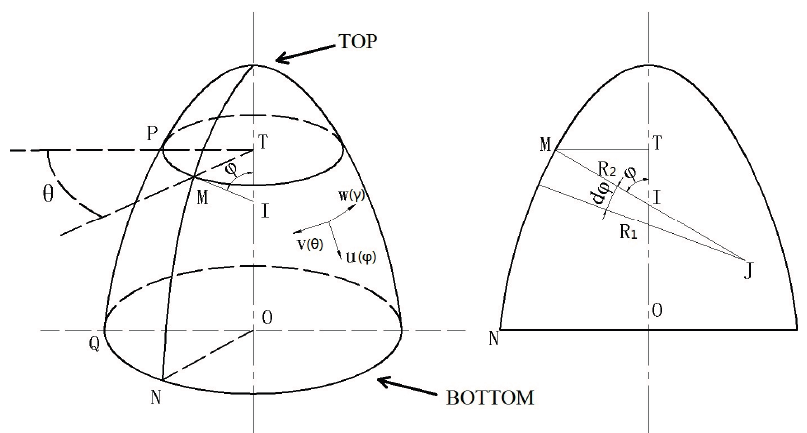
Figure 3. A resonator’s curvilinear